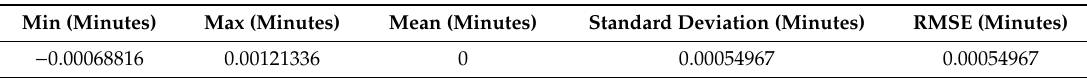
Table 11. Statistical values of the residuals for the longitude coordinates resulting from datum transformation OSPM / ED50 to OSPM / WGS84 based on a conformal approach.